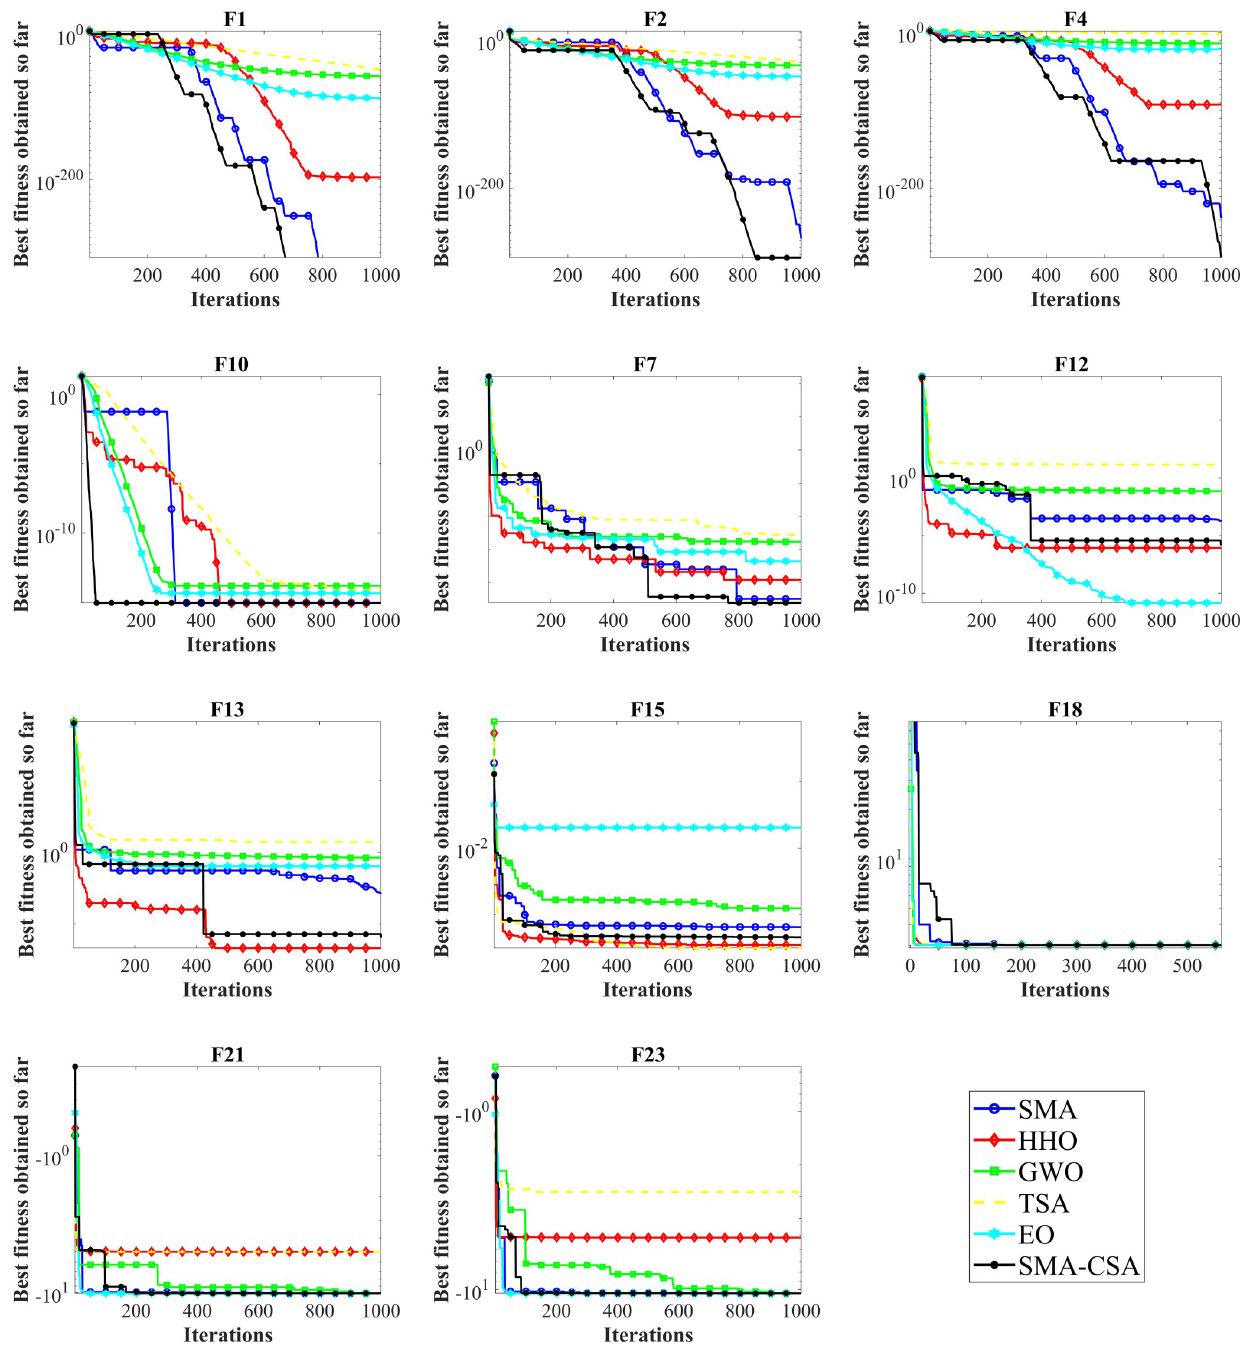
Fig 3. The convergence behavior of the comparative methods using CEC2013 problems. F1-F7 are single-modal benchmark functions; F8-F13 are multimodal benchmark functions; and F14-F23 are composite benchmark